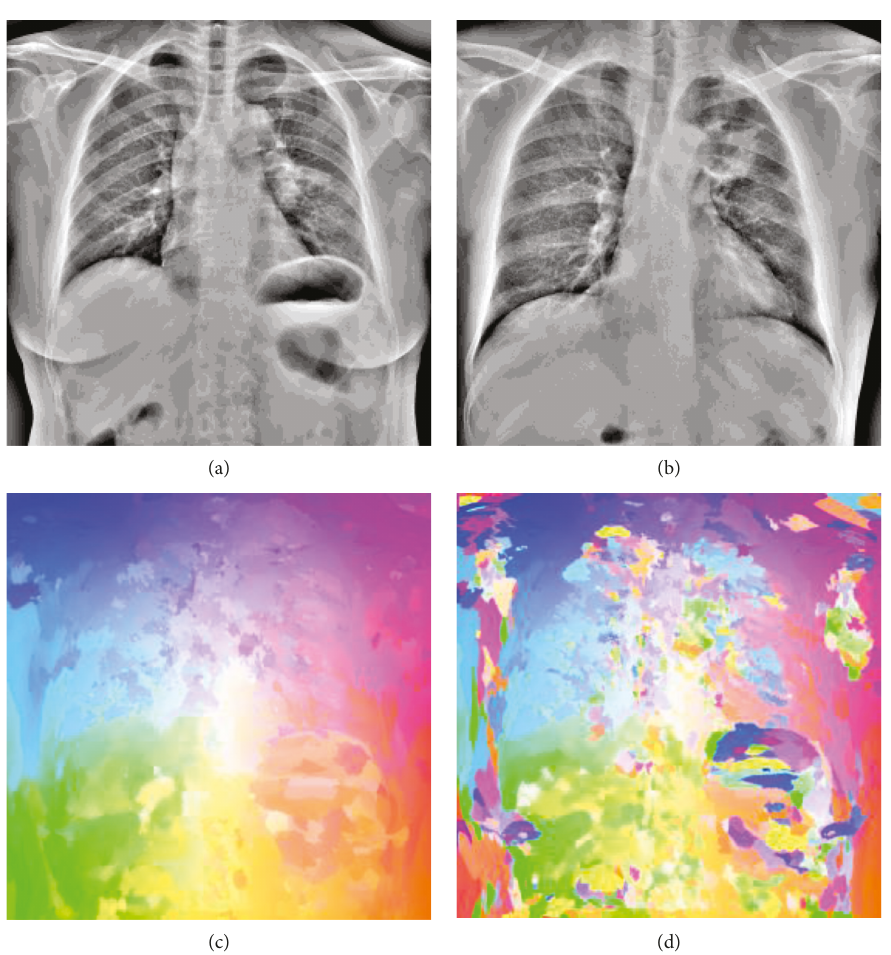
Figure 3: Visualization of corresponding fi